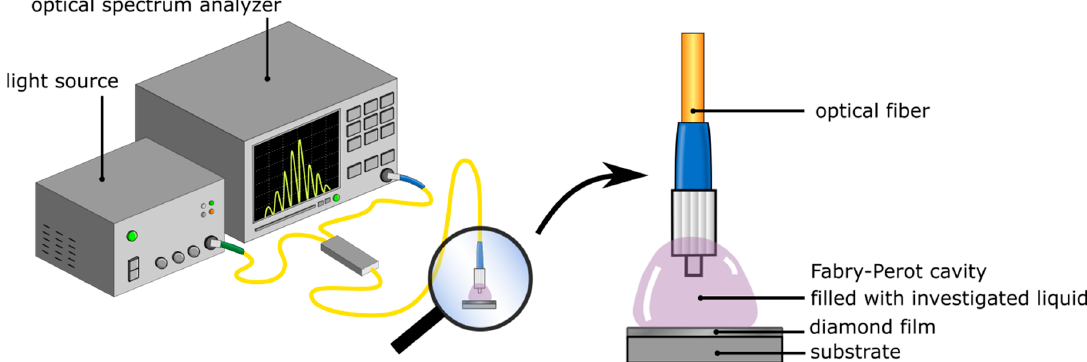
Figure 1. Measurement setup with a close-up of the measurement head.